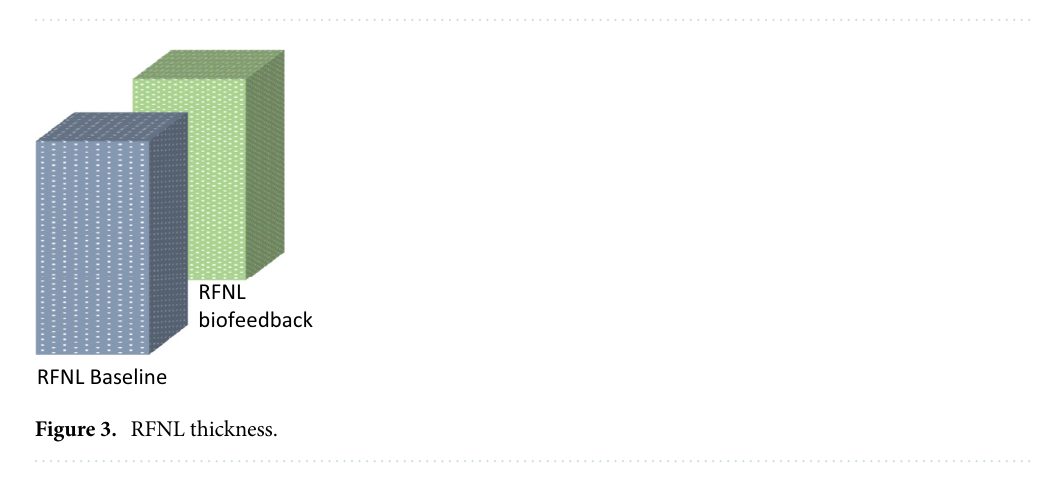
Figure 2. Fixation Stability (BCEA and Fuji %) after biofeedback.